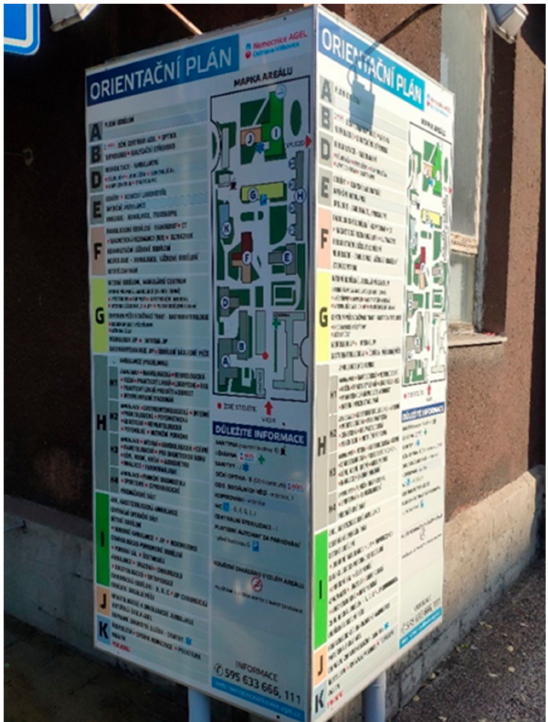
Figure A2. Signs in the V í tkovice Hospital (10/2020). Photo taken by the